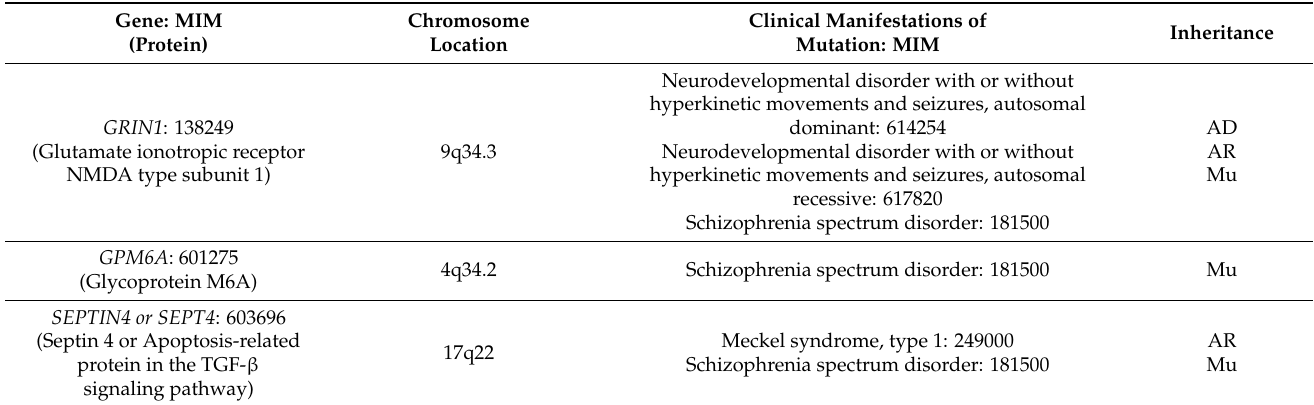
Table 1. Genes responsible for schizophrenia and depression and diseases caused by their mutations (adapted by the authors from